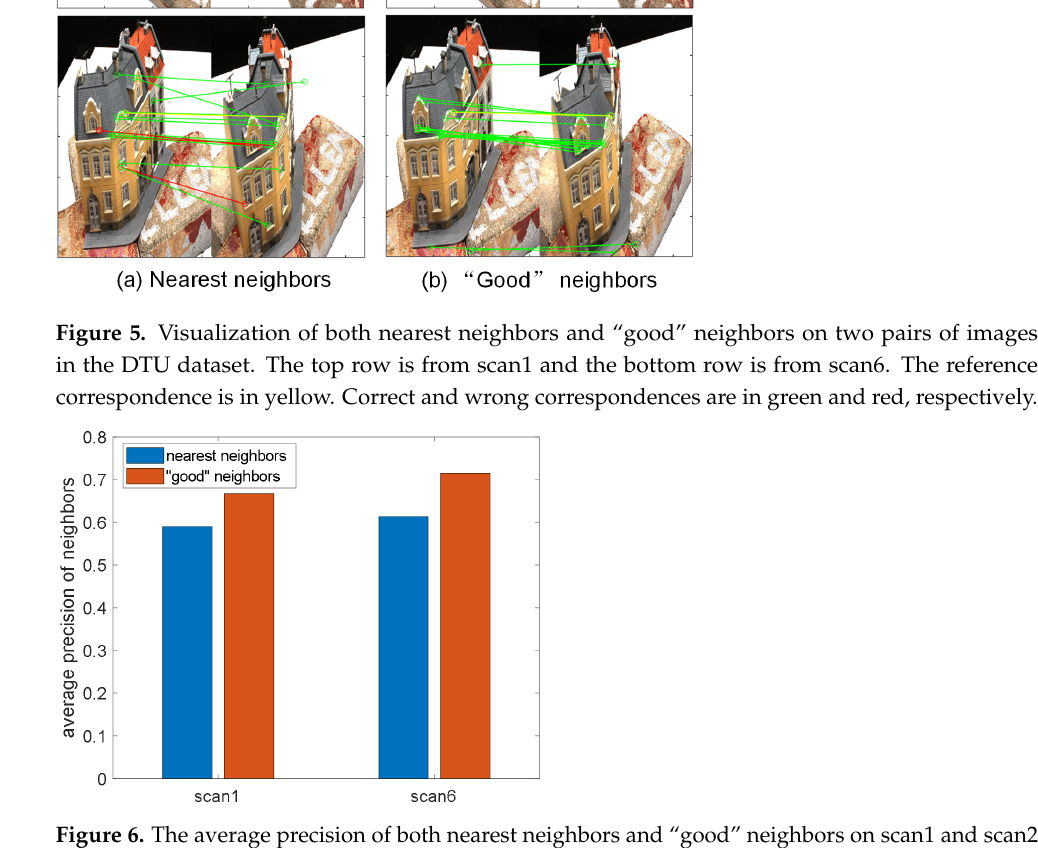
Figure 6. The average precision of both nearest neighbors and “good” neighbors on scan1 and scan2 in the DTU